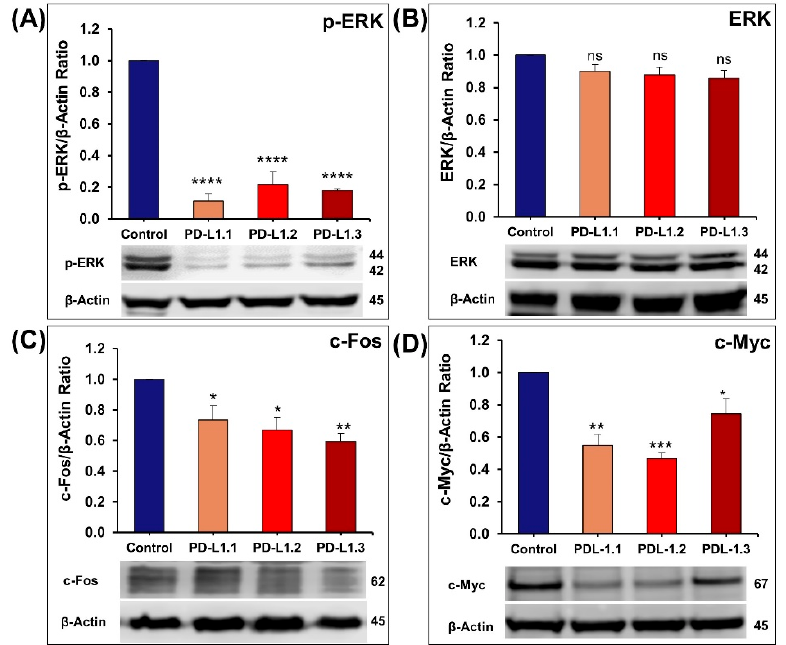
Figure 6. Quantification of the western blot showing the impact of PD-L1 knockout on the expres- sion of p-ERK and total ERK ( A , B ), c-Fos ( C ), and c-Myc ( D ). Columns represent mean of at least three independent experiments; bars represent S.E.M. * p < 0.05. ** p < 0.01. *** p < 0.001. **** p < 0.0001. ns—non-significant.